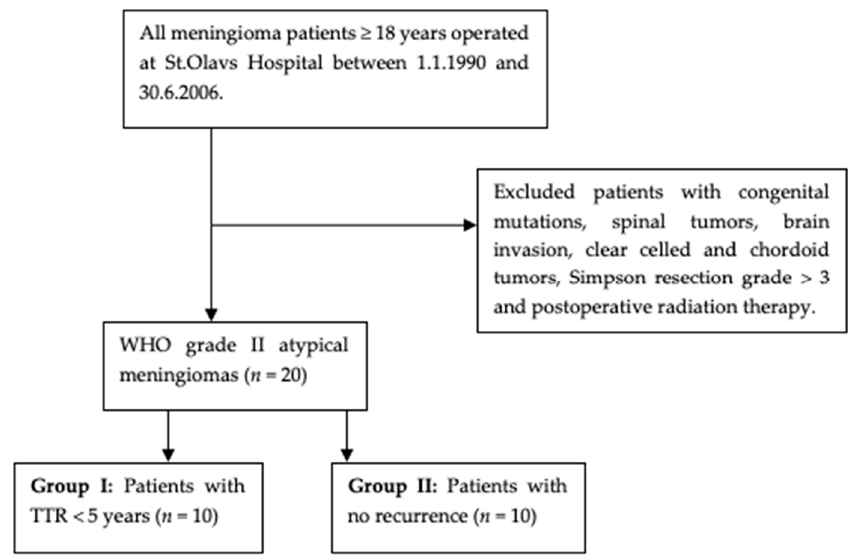
Figure 2. Flowchart of patient selection.